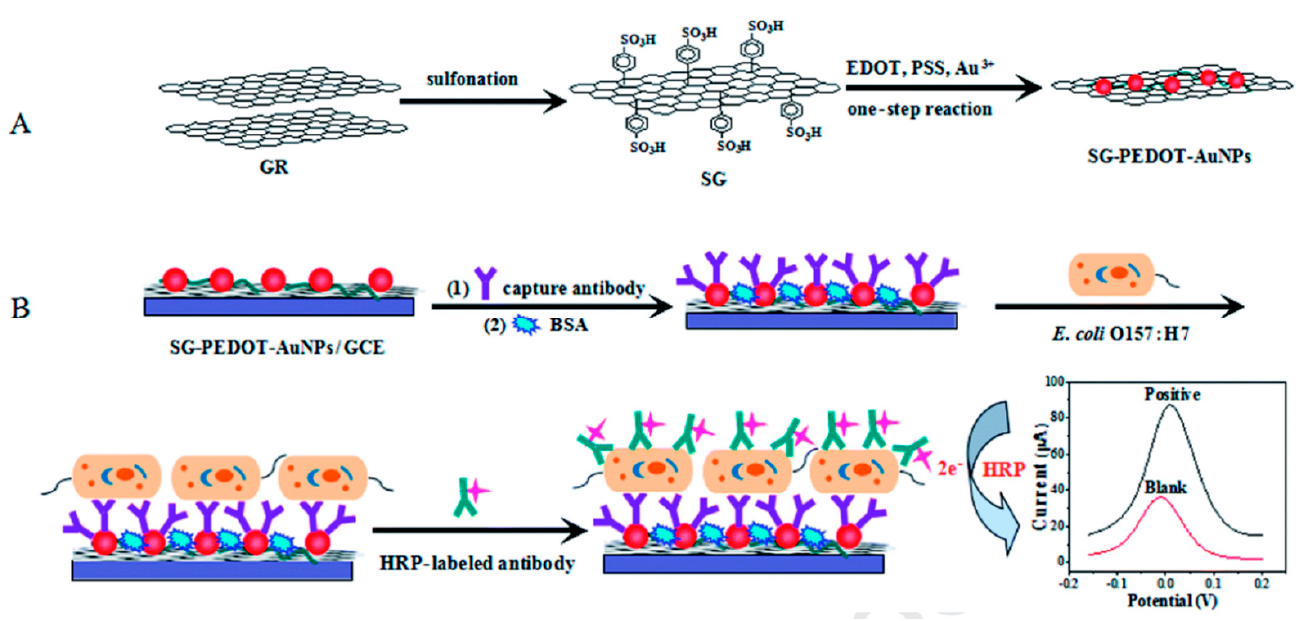
Figure 4. Principle of the sandwich assay. ( A ) Synthesis of sulfonated graphene (SG-PEDOT- AuNPs) composites and Poly-(3,4- 444 ethylenedioxythiophene) (PEDOT) in a single step reaction; ( B ) Schematic representation of electrochemical reaction where antibody was bound on the surface of glassy carbon electrode and detection of target by change in current. Adapted with permission from Ref. [82]. Copyright 2020, Elsevier.